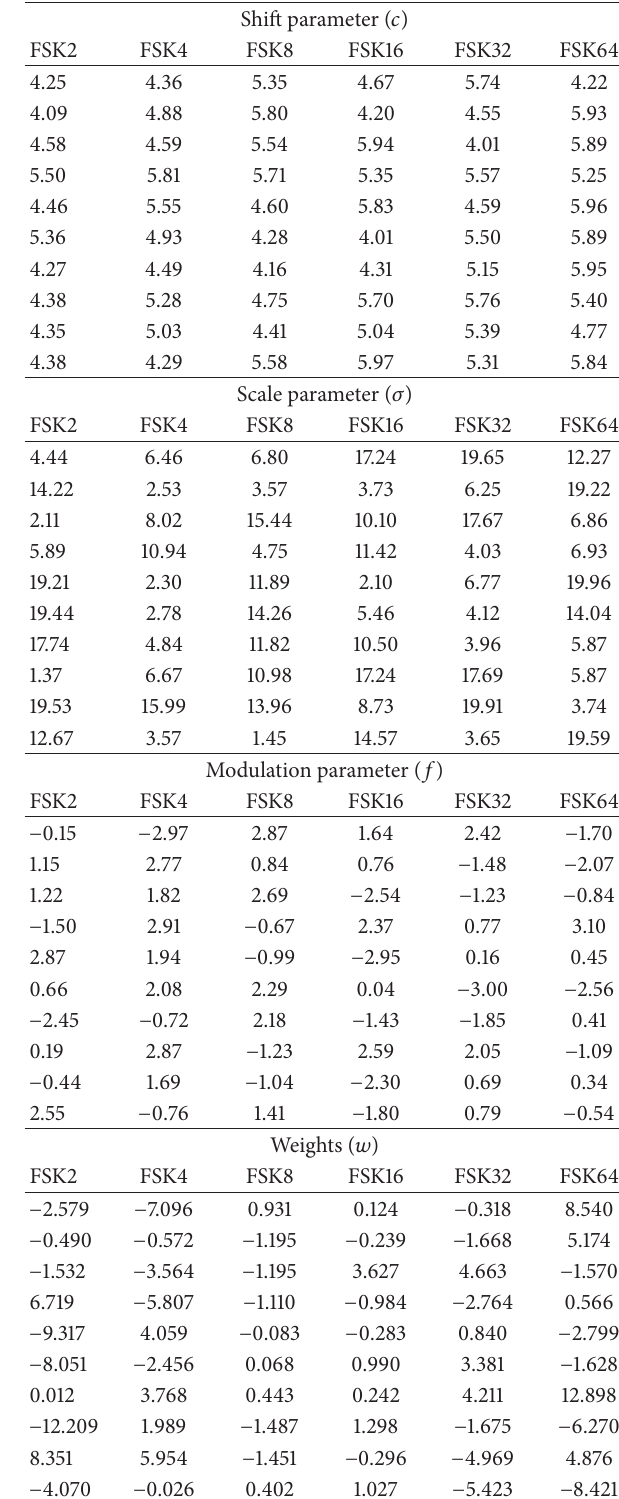
algorithm. The Gabor atom parameters and weights of Gabor